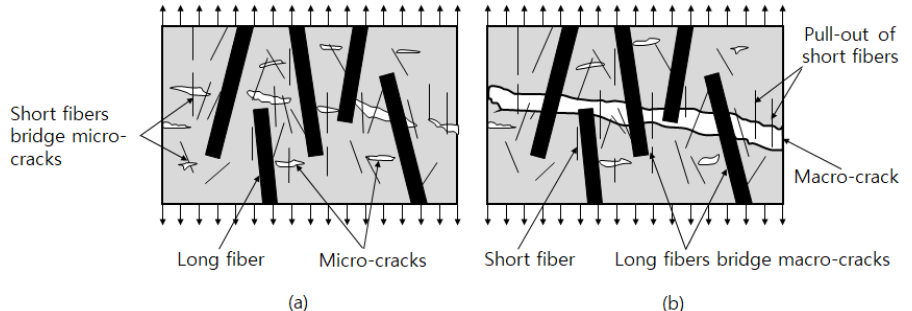
Figure 1. Bridging action of the hybrid with different size; ( a ) first phase of loading, and ( b ) second phase of loading.